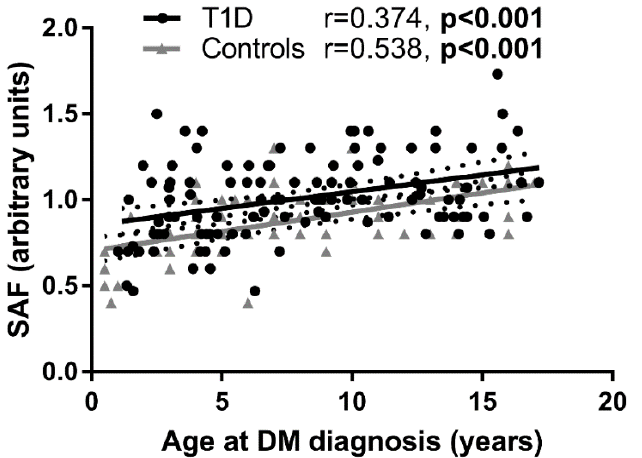
Figure 3. Pearson’s correlation of SAF with age in children and adolescents with newly diagnosed T1D and controls. Dotted lines represent the 95% confidence intervals of the regression line calculated with linear regression analysis. SAF correlated with age at T1D diagnosis in T1D group (Y = 0.01949X + 0.8522, r = 0.374, p < 0.001) and with age at examination in controls (Y = 0.02237X + 0.704, r = 0.518, p < 0.001).